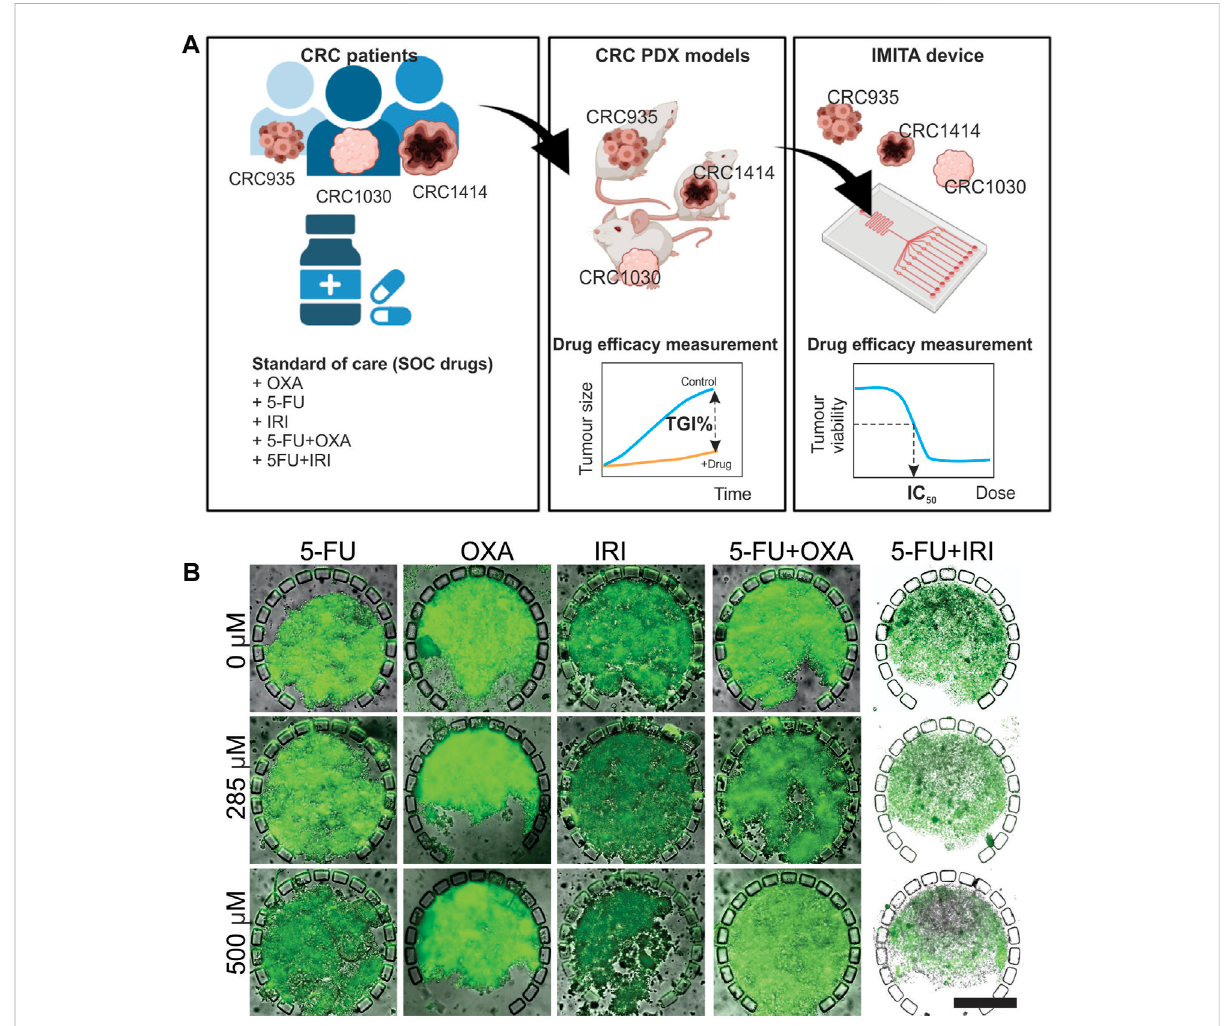
FIGURE 3 In vivo-in vitro comparative study to evaluate the ef fi cacy of 5 standard-of-care (SOC) chemotherapies for 3 CRC patients. (A) Experimental design. The5SOCchemotherapies tested were5-Fluorouracil(5-FU),Oxaliplatin(OXA),irinotecan(IRI),5-Fluorouracil +Oxaliplatin(5-FU+OXAor 5-FU/OXA), and 5-Fluorouracil + irinotecan (5-FU/IRI). Figure created with BioRender.com. (B) Calcein-AM fl uorescent images overlaid with transmission images showing viability of CRC 1414 tumour spheroids in IMITA devices after 24 h of treatment with 5 SOC chemotherapies at selected concentrations. Magni fi cation = ×10. Scale bar = 250